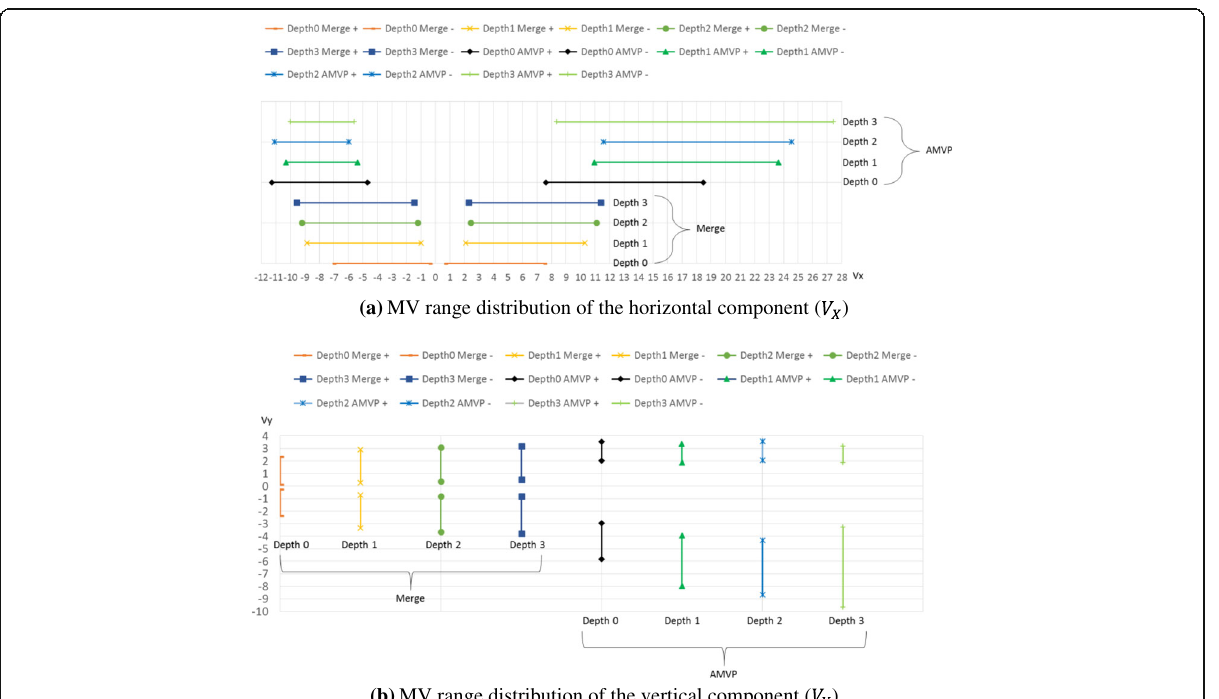
Fig. 12 MV range distribution of the ( a ) horizontal component ( V X ) and ( b ) vertical component V Y of the S03 sequence at QP22